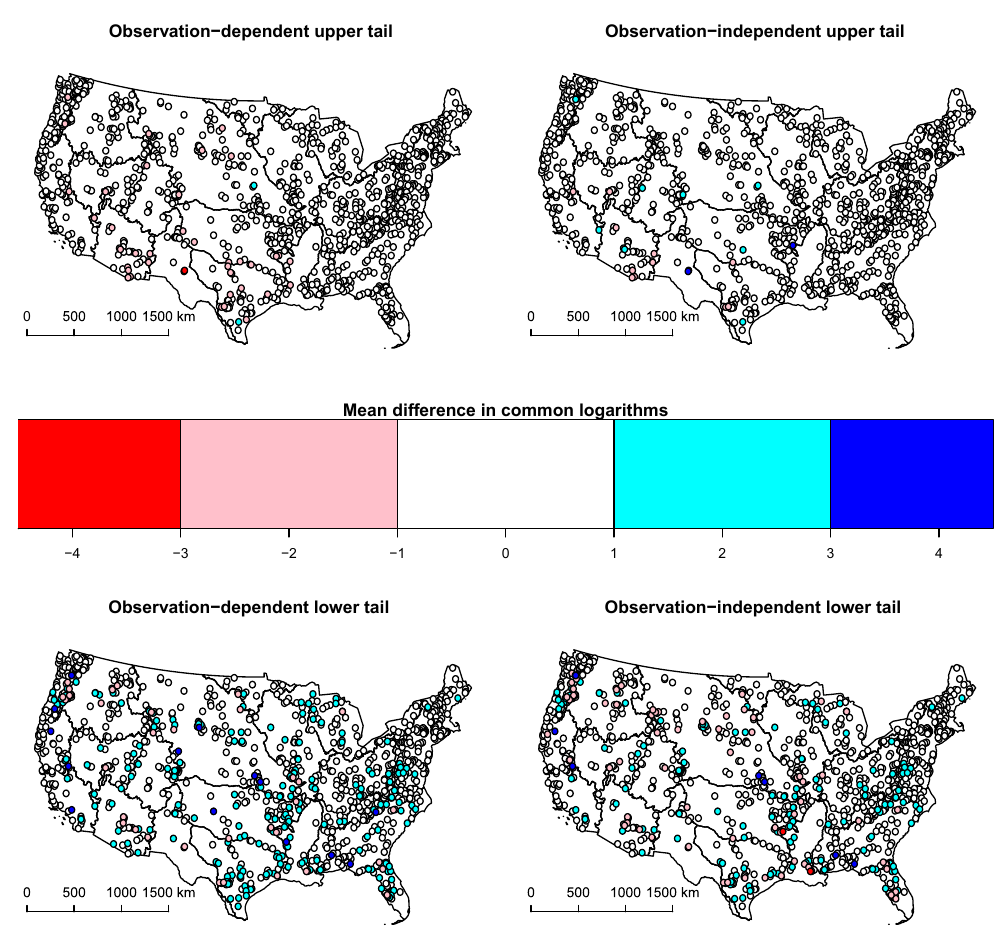
Figure 7. Maps showing the distribution of logarithmic bias, measured as the mean difference between the common logarithms of simulated and observed streamflow (simulated minus observed) at 1168 streamgages across the conterminous USA for observation-dependent and observation-independent upper and lower tails. Observation-dependent tails retain the ranks of observed streamflow, while matching simu- lations by day. Observation-independent tails rank observations and simulation independently. The upper tail considers the highest 5% of streamflow, while the lower tail considers the lowest 5% of streamflow. The bias is derived from the original simulation of daily streamflow using pooled ordinary kriging at 1168 sites regionalized by the two-digit hydrologic units